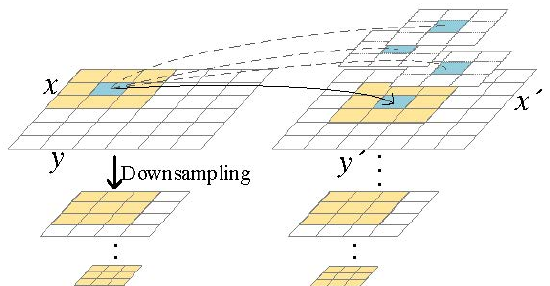
Figure 2. The patch search process in optical flow estimation. The best match is determined by minimizing the P error of a small block around the pixel, and the pixel ( x , y ) in the current view is mapped to the (𝑥 (cid:4593) , 𝑦 (cid:4593) ) pixel position of the adjacent view.